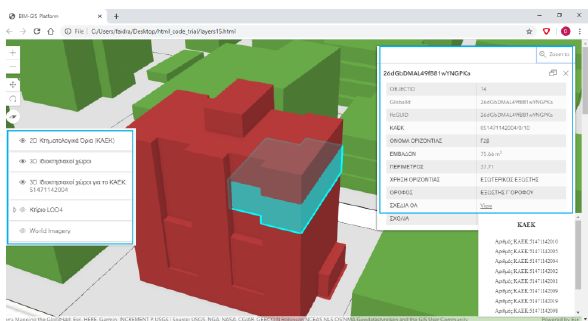
Figure 5. User’s interface of BIM-GIS Platform after an entity being selected.